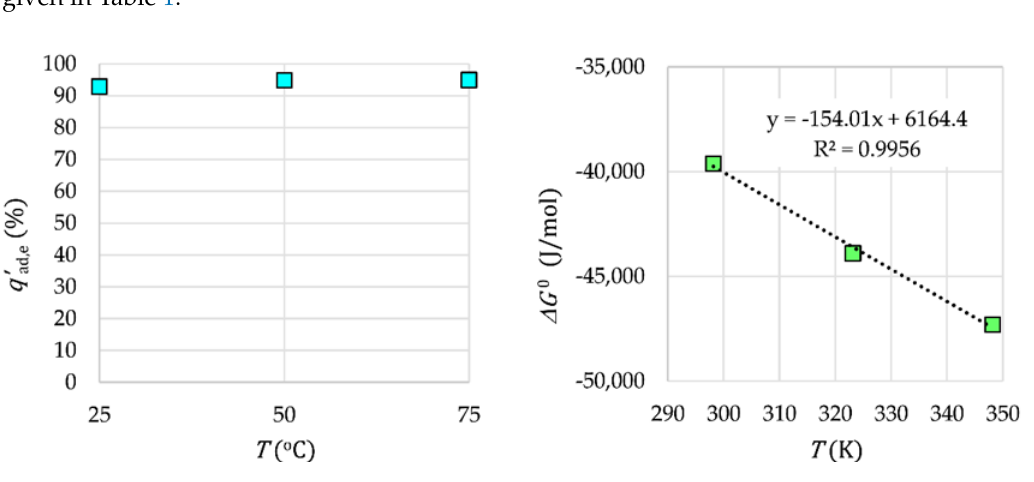
Figure 13. The influence of temperature and thermodynamics for Tb 3 + adsorption. Table 1. Thermodynamic